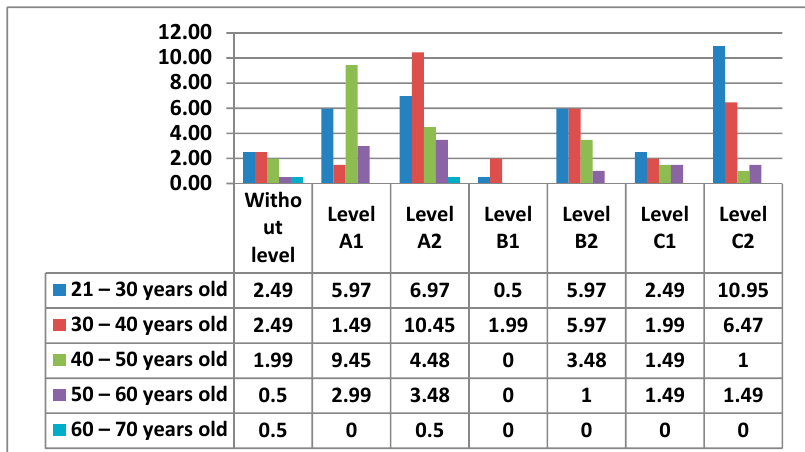
Figure 14. Level of digital competence in teachers in Area 2.